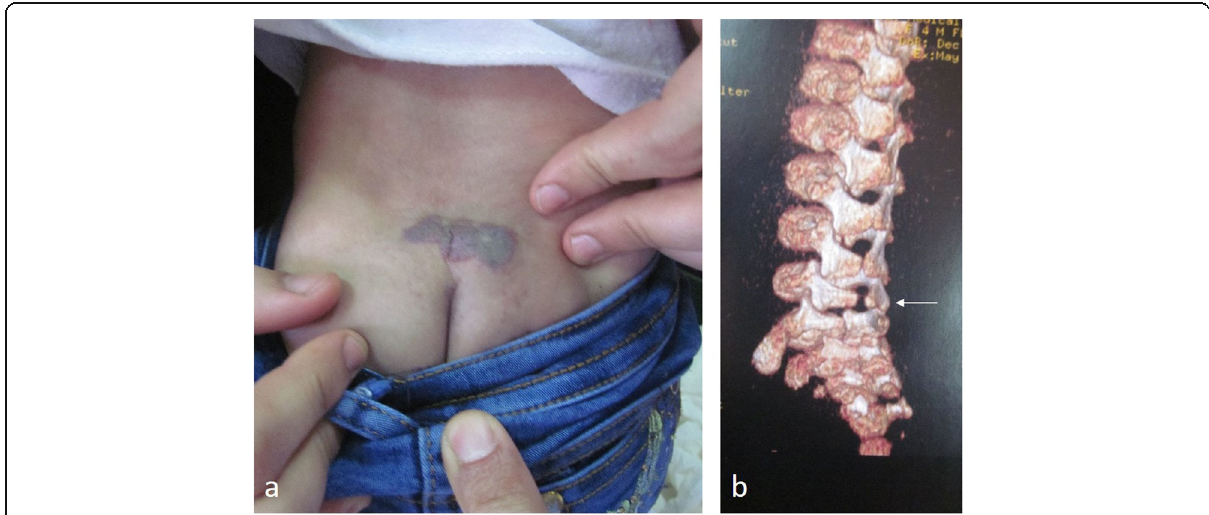
Fig. 9 Infantile haemangioma presenting as a midline back lesion ( a ) that was associated with spina bifida occulta demonstrated by white arrow in ( b